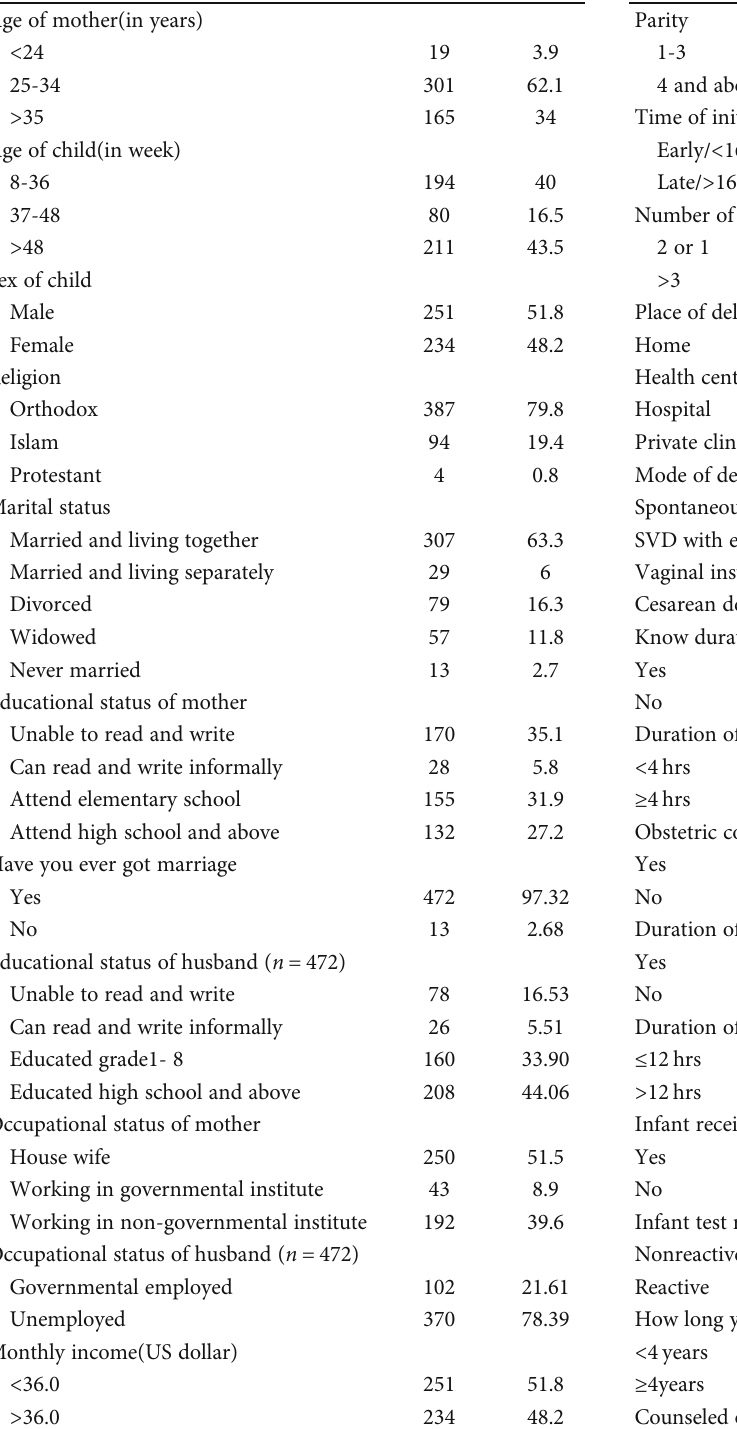
Table 2: Obstetrics related characteristics of HIV-positive women in care in public health institutions in Gondar city, Northwest Ethiopia, 2017 ( n = 485